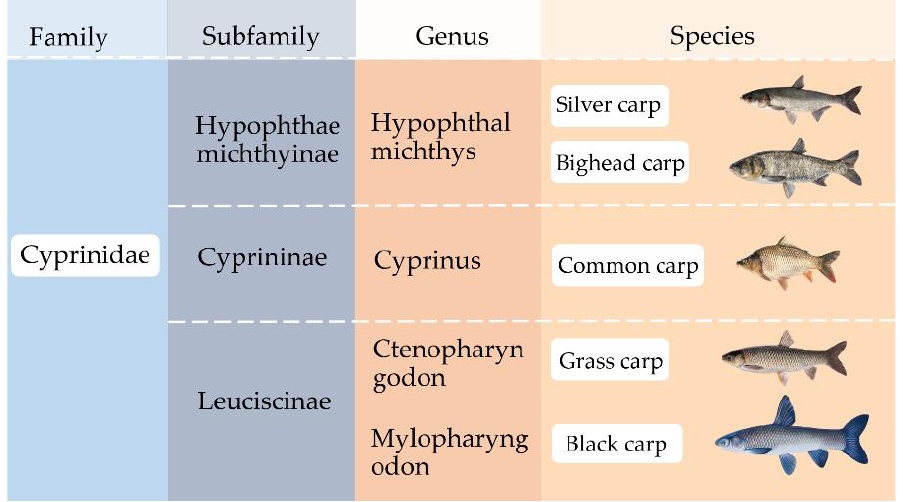
Figure 1. Genealogy of Asian carp.